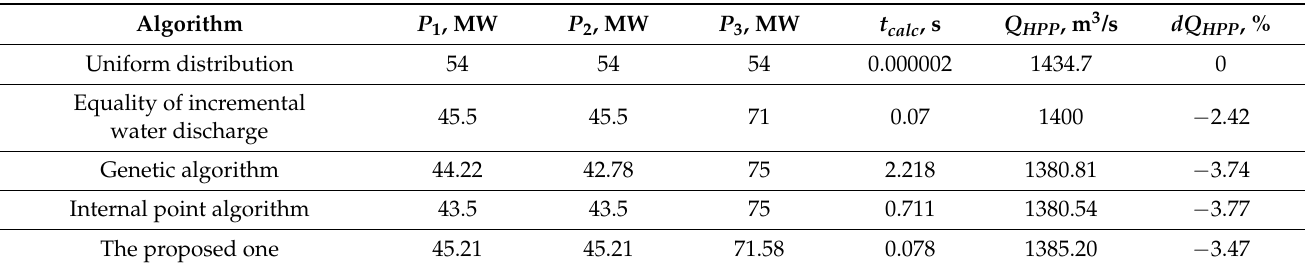
Figure 5. Incremental water discharge versus turbine power graphs for hydraulic units of Novosibirsk HPP and the solution of the Equation (17). Table 2. Power Distribution Algorithm Comparison Results.